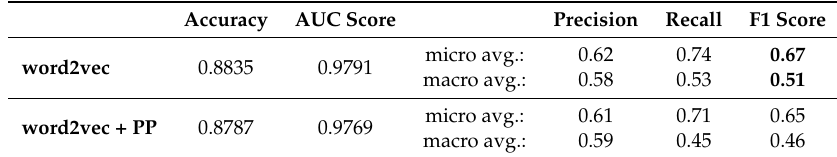
Table 8. Performance of the composed BiLSTM + CNN model with gensim word2vec embeddings.